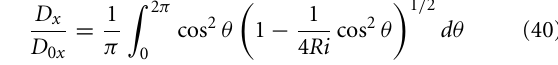
line), from the corresponding high- Ri asymptotic limit (dotted line), and from numerical simulations (symbols). Reproduced from Figures 1, 7 of Teixeira et al. [50]. © American Meteorological Society. Used with